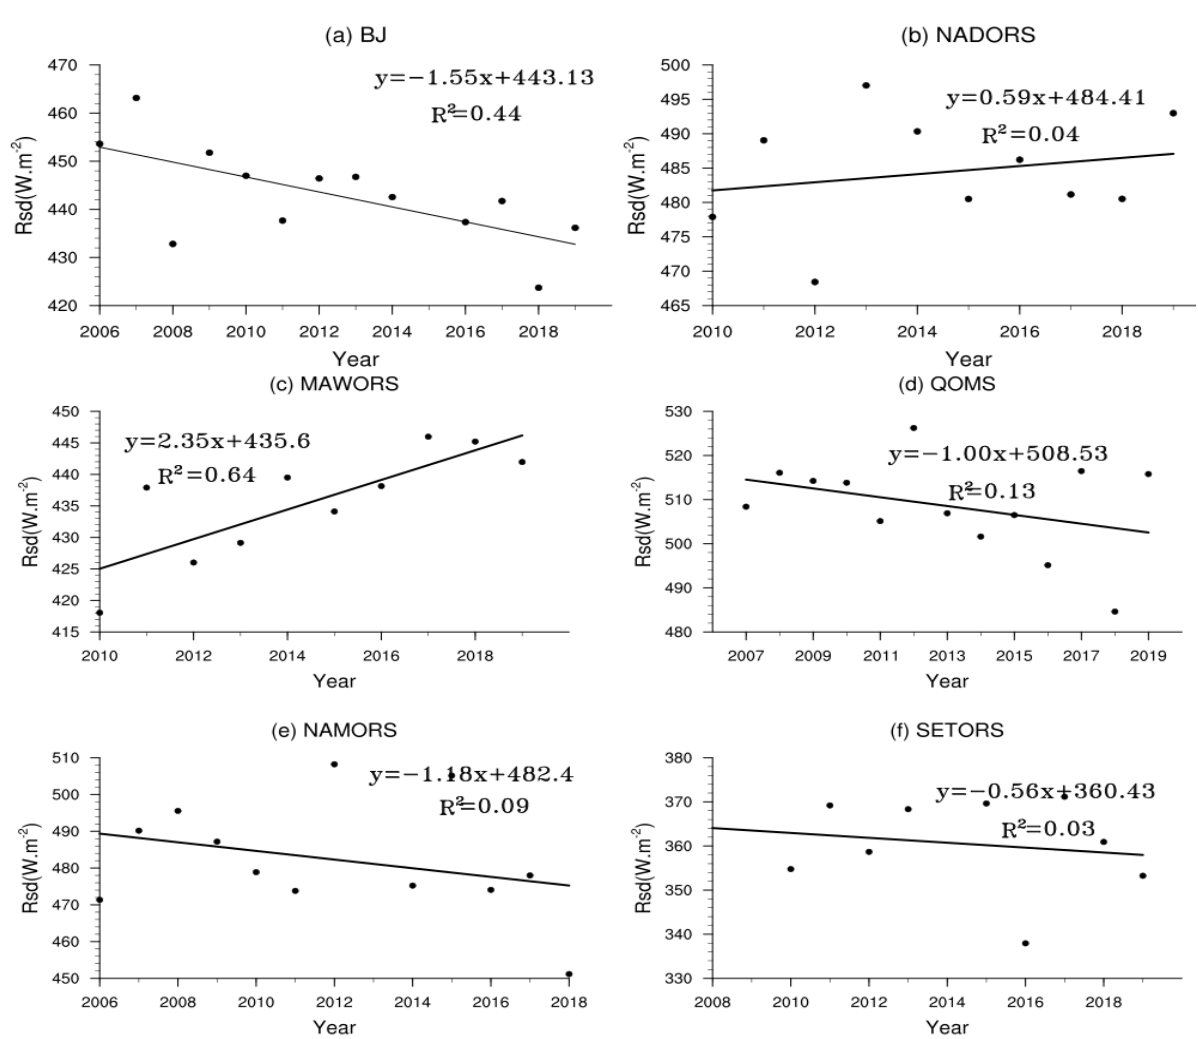
Figure 5. Interannual variation of downward shortwave radiation at each station.